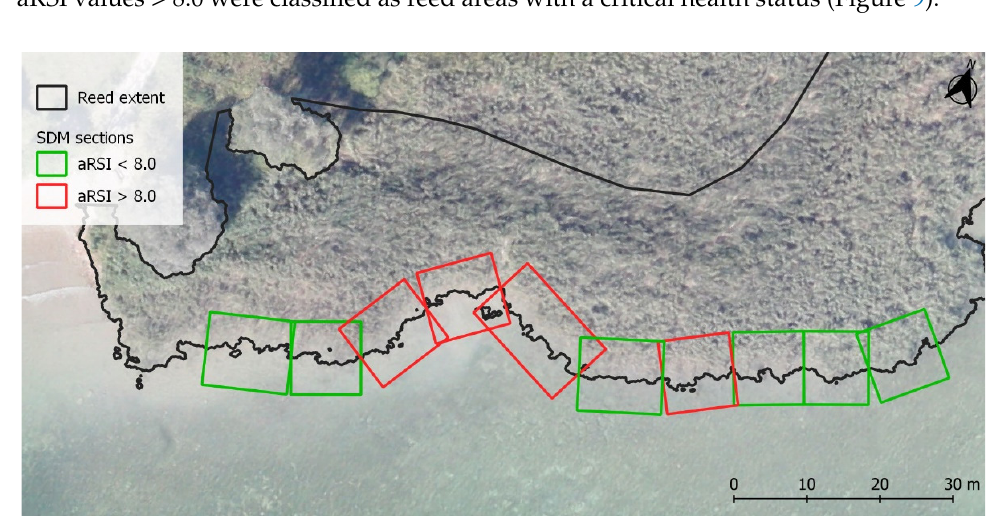
Figure 9. Aquatic reed status estimation at AOI 6. Aquatic reeds can be assumed as under pressure in sections in red. Healthy reed sections are shown in green. Table 4. Accuracy matrix for the status estimation derived by a combinatorial approach.